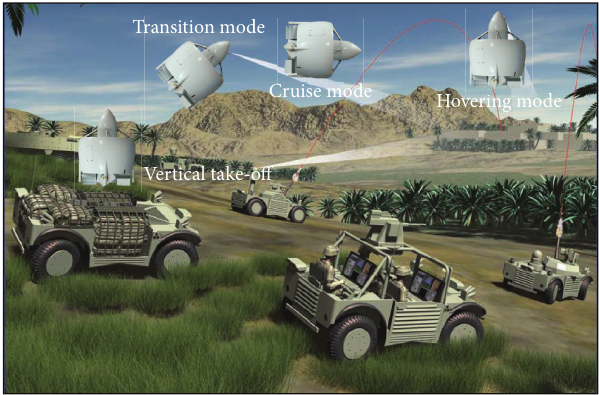
Figure 1: Operation concept of the ducted-fan